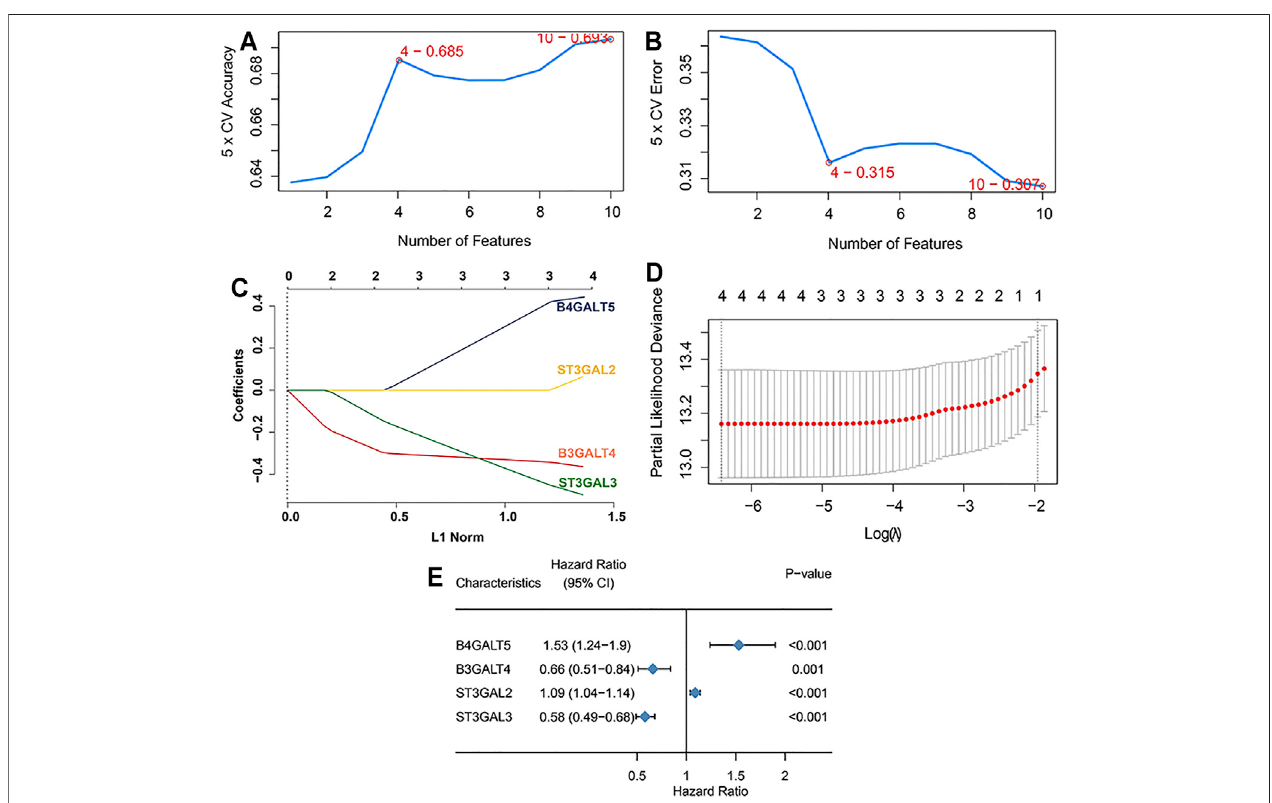
FIGURE 3 | Construction of GTscore with machine learning in the training set. The accuracy (A) and the error (B) of the estimate generation for the SVM-RFE algorithm. (C) Ten-time cross-validation was performed for tuning parameter selection through the LASSO regression model. (D) LASSO coef fi cient pro fi les of prognostic GTs. (E) Forest plot showing the HR with 95% CI of prognostic GTs.